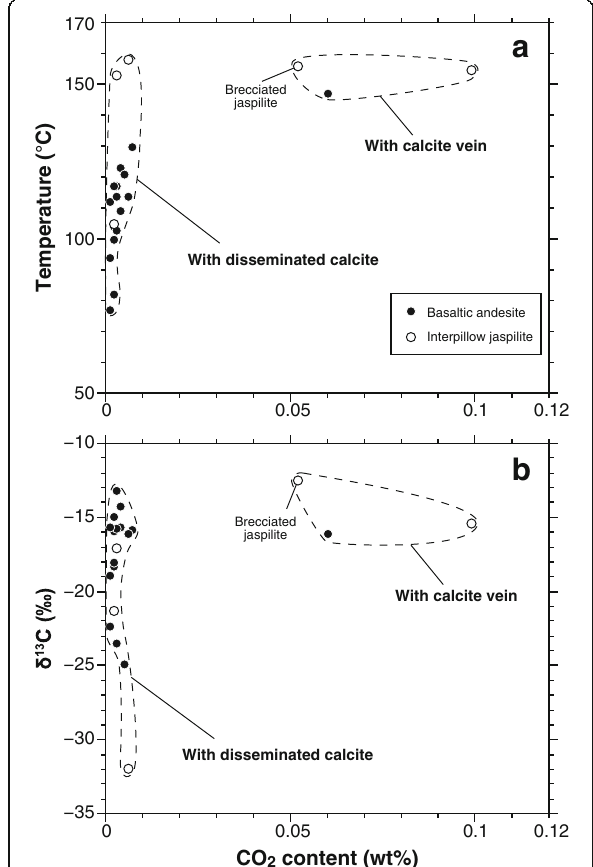
Fig. 5 Content of CO 2 fixed as carbonate vs. a temperature obtained from δ 18 O values and b δ 13 C values ( ‰ , VPDB) of calcites from the Ongeluk basaltic andesites and hydrothermal jaspilites. The deformed samples (brecciated or with calcite vein) have higher CO 2 content than the undeformed